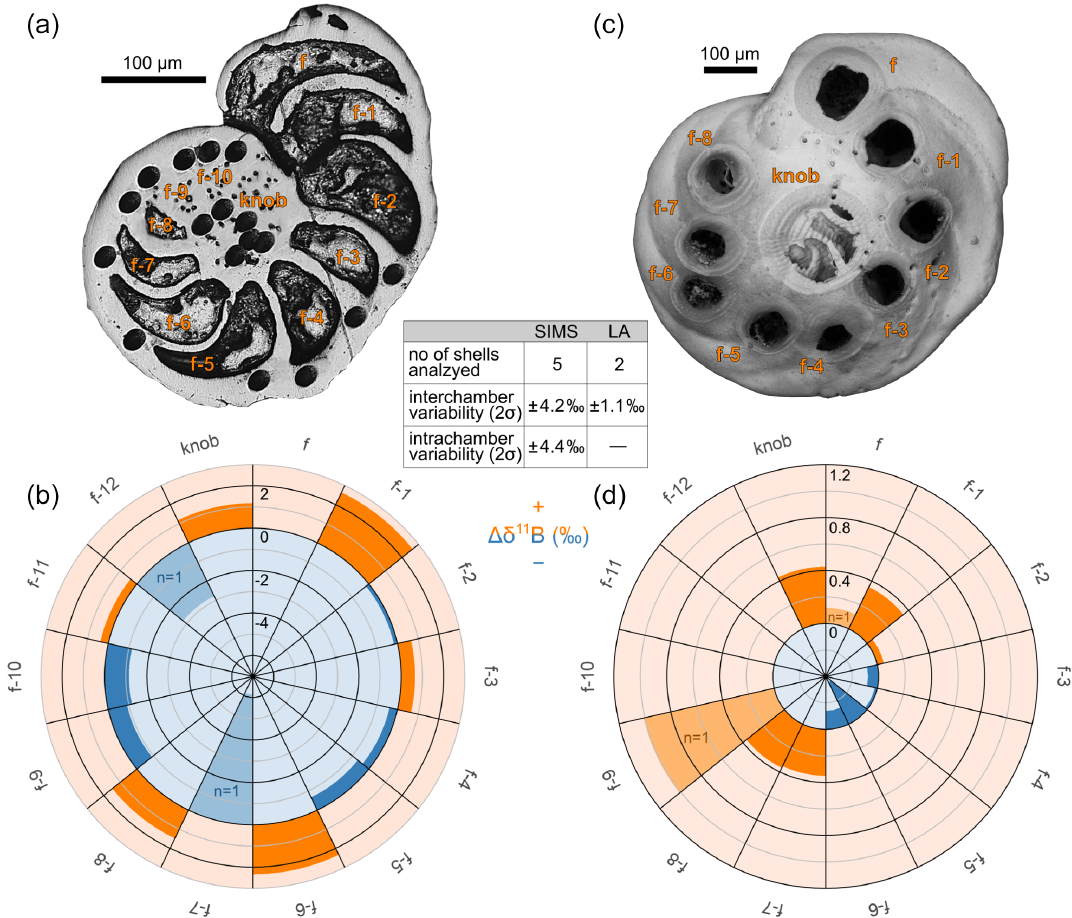
Figure 4. Intra-shell variability of δ 11 B using SIMS (a) and LA-MC-ICPMS (b) on selected large individuals of C. wuellerstorfi . The residual (cid:49)δ 11 B (difference between single-spot and mean δ 11 B, Eq. 2) averaged from all analyzed specimens is shown for each chamber ( f is the final chamber, f − 1 the penultimate one, and so on). Orange color stands for higher-than-mean and blue for lower-than-mean values. Lighter colors indicate data that are based on only one measurement. The inset table summarizes the measured intra-shell variability derived from the two